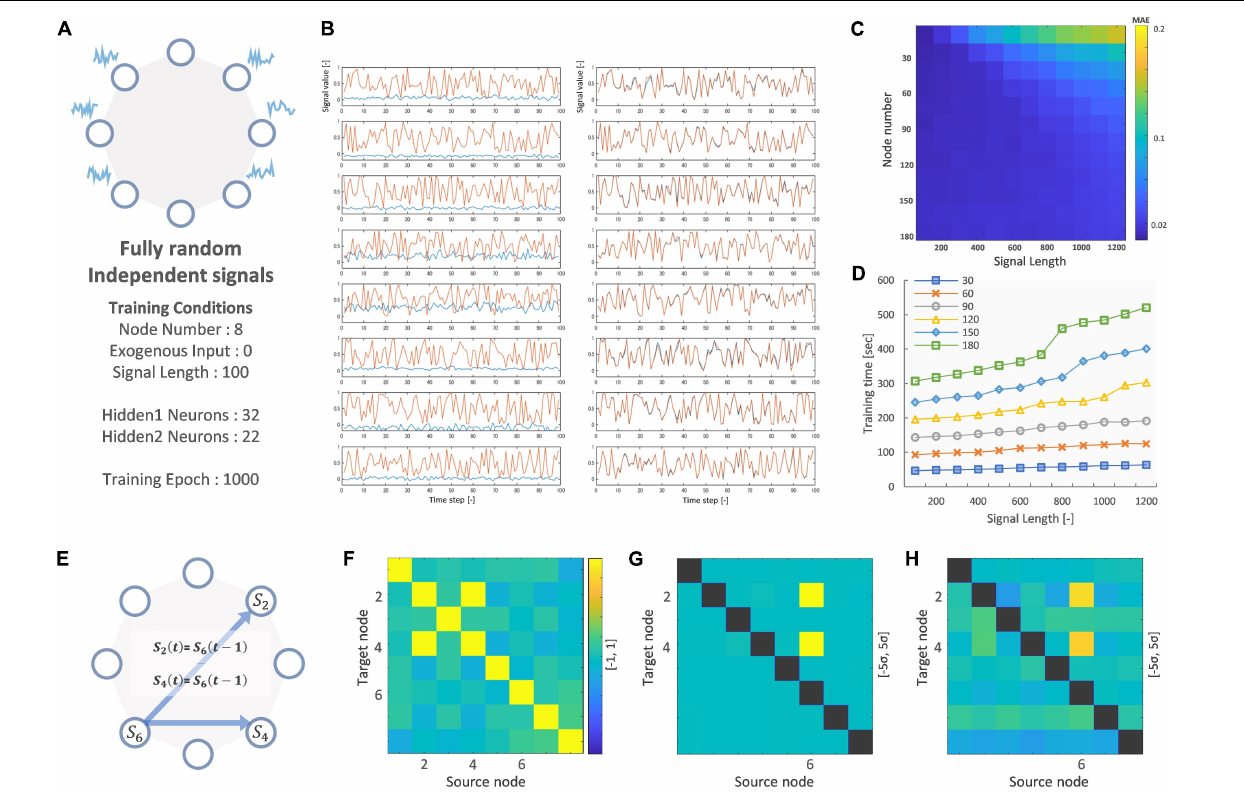
Supplementary Figure 1 . Before training, the VARDNN nodes output signals clearly different from the teacher data, but after training with the conditions depicted in Figure 2A , the VARDNN nodes were able to output signals similar to the teaching signal ( Figure 2 ). Before training, the mean absolute error (MAE) was 0.456 and after training it became 0.018. Figures 2C,D show some performance measures for VARDNN training. The MAE and training time were measured while changing the number of nodes and signal length, with the number of training epochs = 1,000.